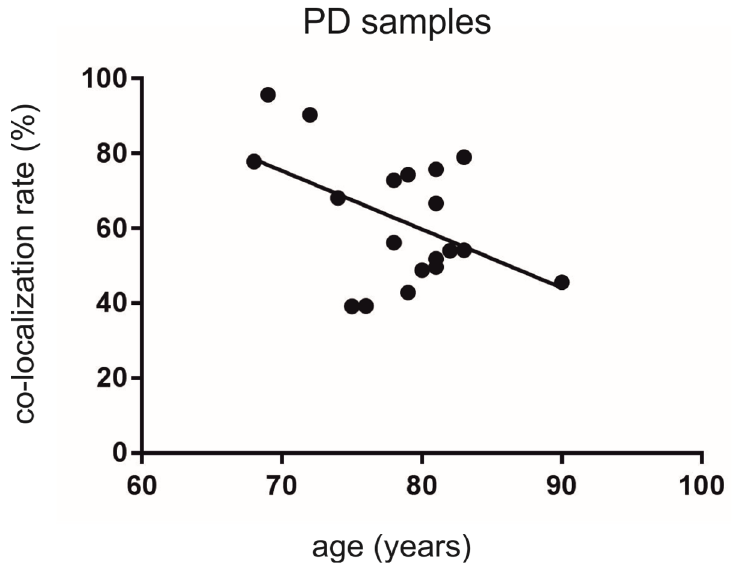
Figure 5. Analysis of the co-localization rates of TH-ir neurons also expressing Nogo-A depending on the age in the human SNc from PD individuals. There was a significant association with increasing age, showing lower levels of co-localization ( p < 0.05).